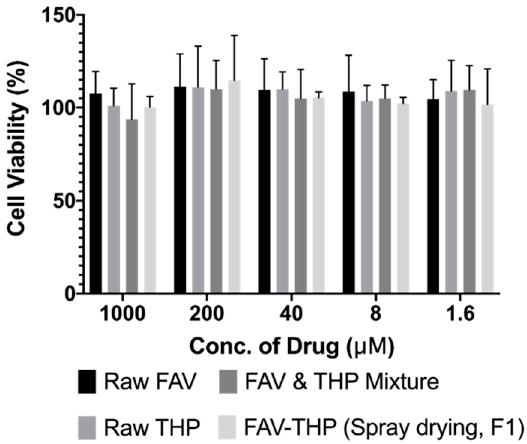
Figure 11. Cell viability of the raw drugs, the physical mixture and the spray-dried F1 at concentra- tions from 1.6 to 1000 μ M. tions from 1.6 to 1000 µ